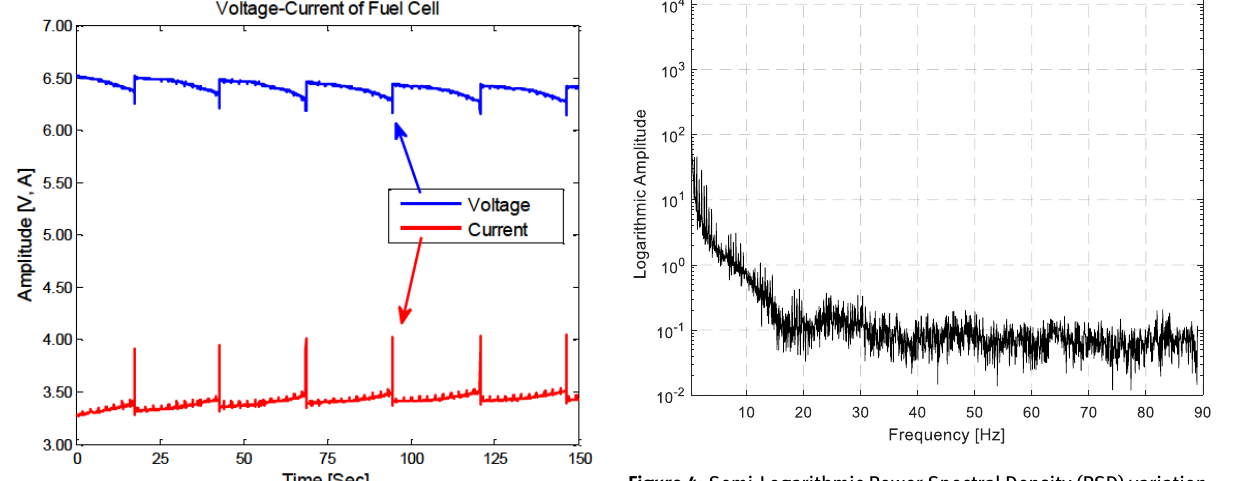
Figure 4: Semi-Logarithmic Power Spectral Density (PSD) variation for voltage